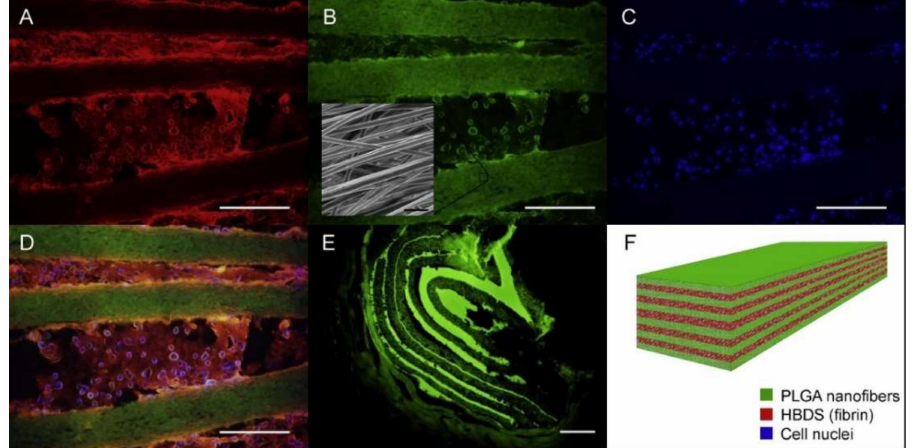
Figure 7. A representative HBDS / nanofiber sca ff old with 11 alternating layers of aligned electrospun PLGA nanofiber mats separated by HBDS containing 1 × 10 6 ASCs is shown. ( A – D ) Micrograph showing the HBDS / nanofiber sca ff old in vitro; the PLGA is labeled with FITC (green), the HBDS is labeled with Alexa Fluor 546 (red), and the ASC nuclei are labeled with Hoescht 33258 (blue) (scale bar = 200 µ m). ( B , inset) SEM image of the sca ff old showing PLGA nanofiber alignment. ( E ) Micrograph showing the HBDS / nanofiber sca ff old in vivo nine days after implantation in tendon repair. Eleven alternating layers of PLGA and HBDS can be seen (i.e., six layers of PLGA and five layers of fibrin); the PLGA is labeled with FITC (green) (scale bar = 100 µ m). ( F ) A schematic of the layered sca ff old is shown [86]. Reproduced with permission from Elsevier,